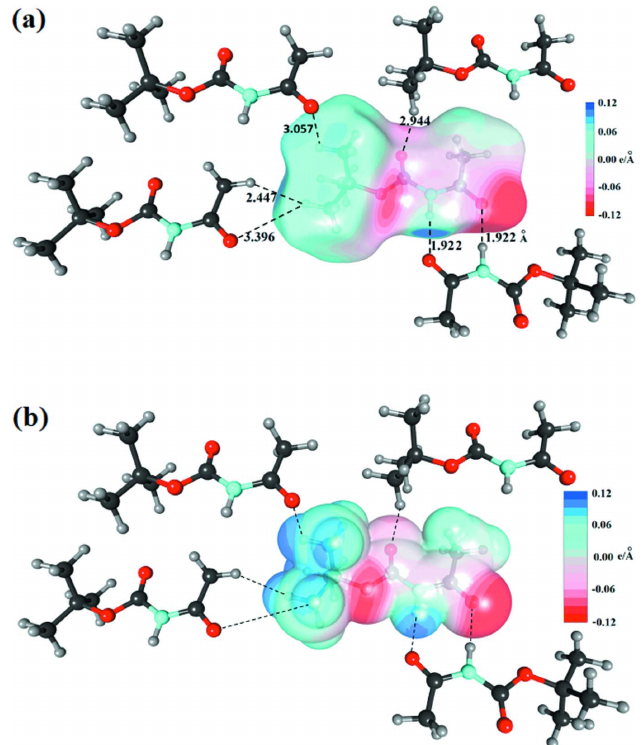
Figure 5 ( a ) Hirshfeld and ( b ) van der Waals surfaces around molecule (I). The N—H (cid:2)(cid:2)(cid:2) O and C—H (cid:2)(cid:2)(cid:2) O hydrogen bonds as well as a short H (cid:2)(cid:2)(cid:2) H contacts are shown. The surfaces are coloured according to the electrostatic potential.